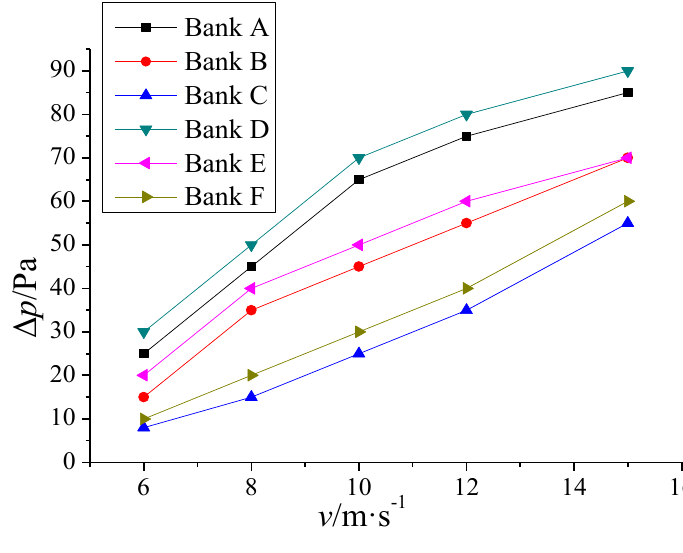
Figure 7. Relationship between pressure drop and air